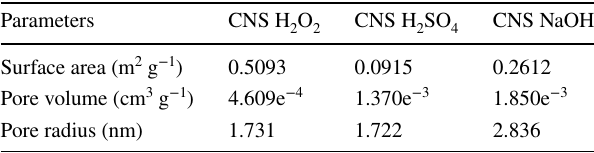
in natura (Coelho et al. PZC ) of CNS